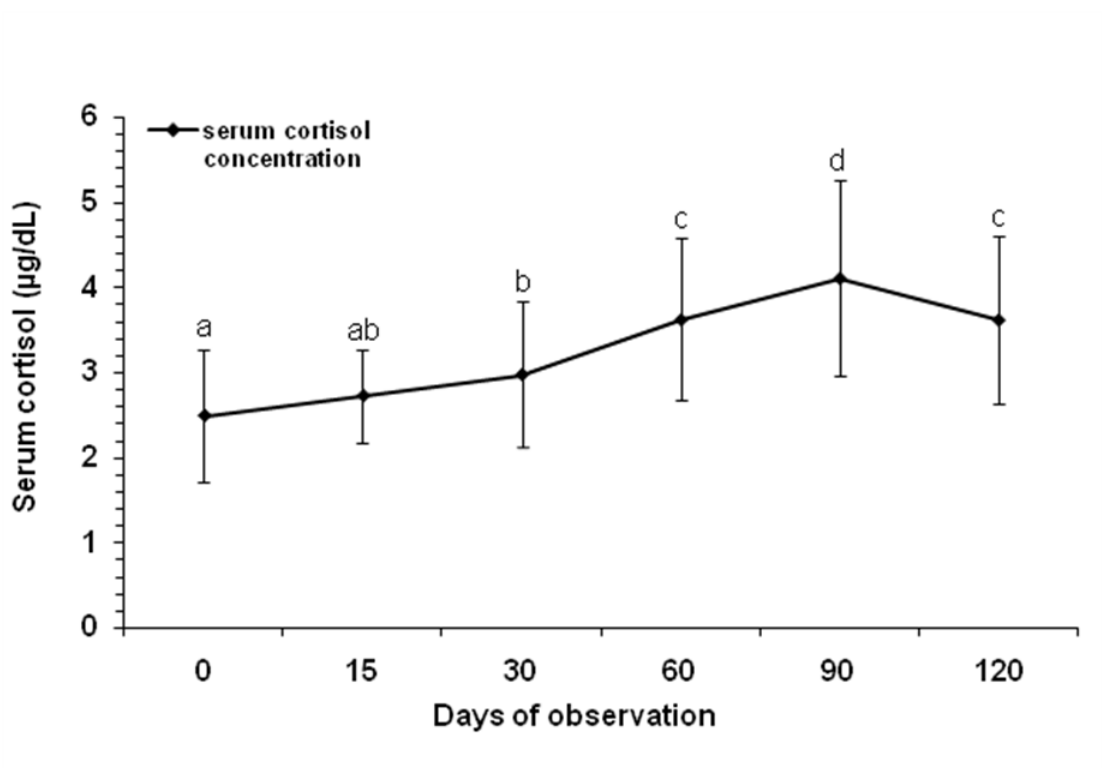
Figure 1. Mean serum cortisol levels (± SD) in cattle throughout repeated handling procedures. Data were pooled for groups Gc, G least one same letter were statistically equal (ANOVA; F P <